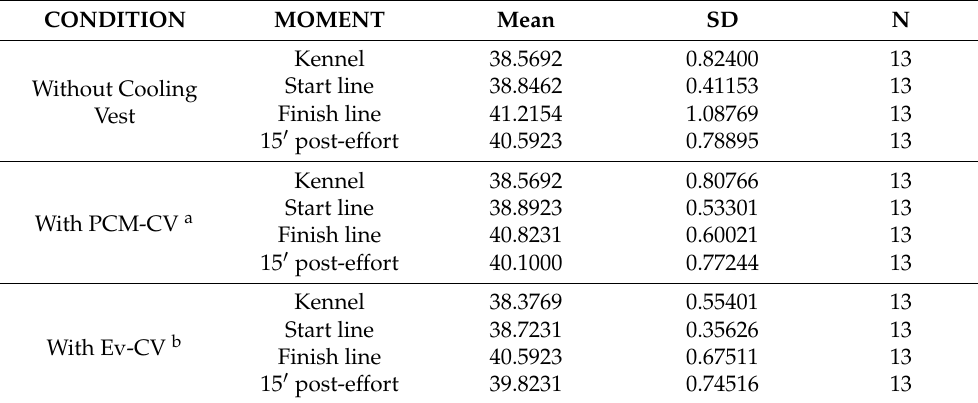
Table 4. Mean values and standard deviations for the dogs’ core body temperature ( ◦